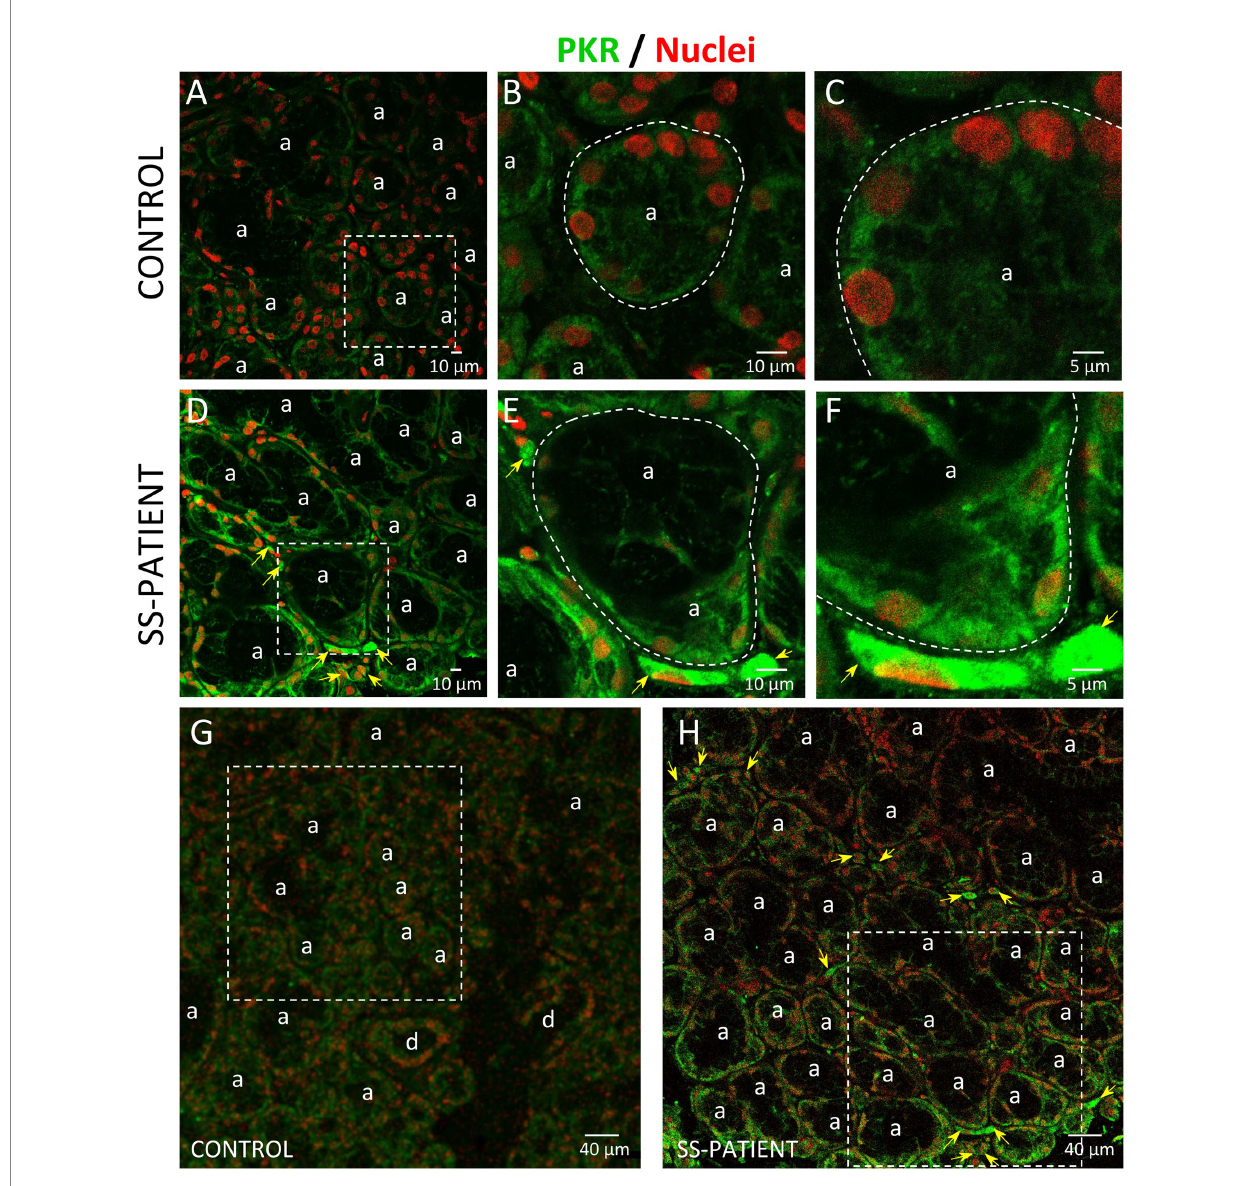
FIGURE 3 Localization of PKR in LSGs from controls and SS-patients. (A–C,G) PKR (green) staining was mainly observed in the basolateral cytoplasm of epithelial cells in LSG from control subjects. (D–F,H) Stronger PKR (green) staining was observed in the cytoplasm of epithelial and plasma cells (yellow arrows) in LSGs from SS-patients. (A,D) Higher magnifications of regions bounded by broken lines in G and H, respectively. (B,C,E,F) Higher magnifications of regions bounded by broken lines in A and B, respectively. Nuclei (red) were counterstained with Hoechst-33342. a: acini. Bars A, B, D and E: 10 μ m; C and F: 5 μ m; G and H: 40 μ